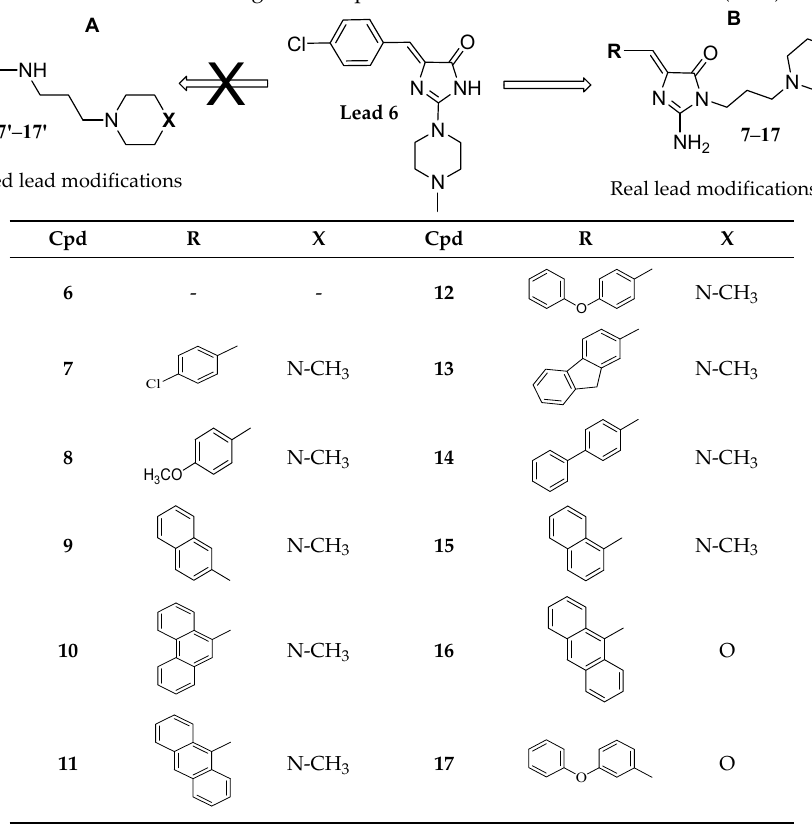
Table 1. Structure of investigated compounds: lead 6 and its modifications ( 7 – 17 ).